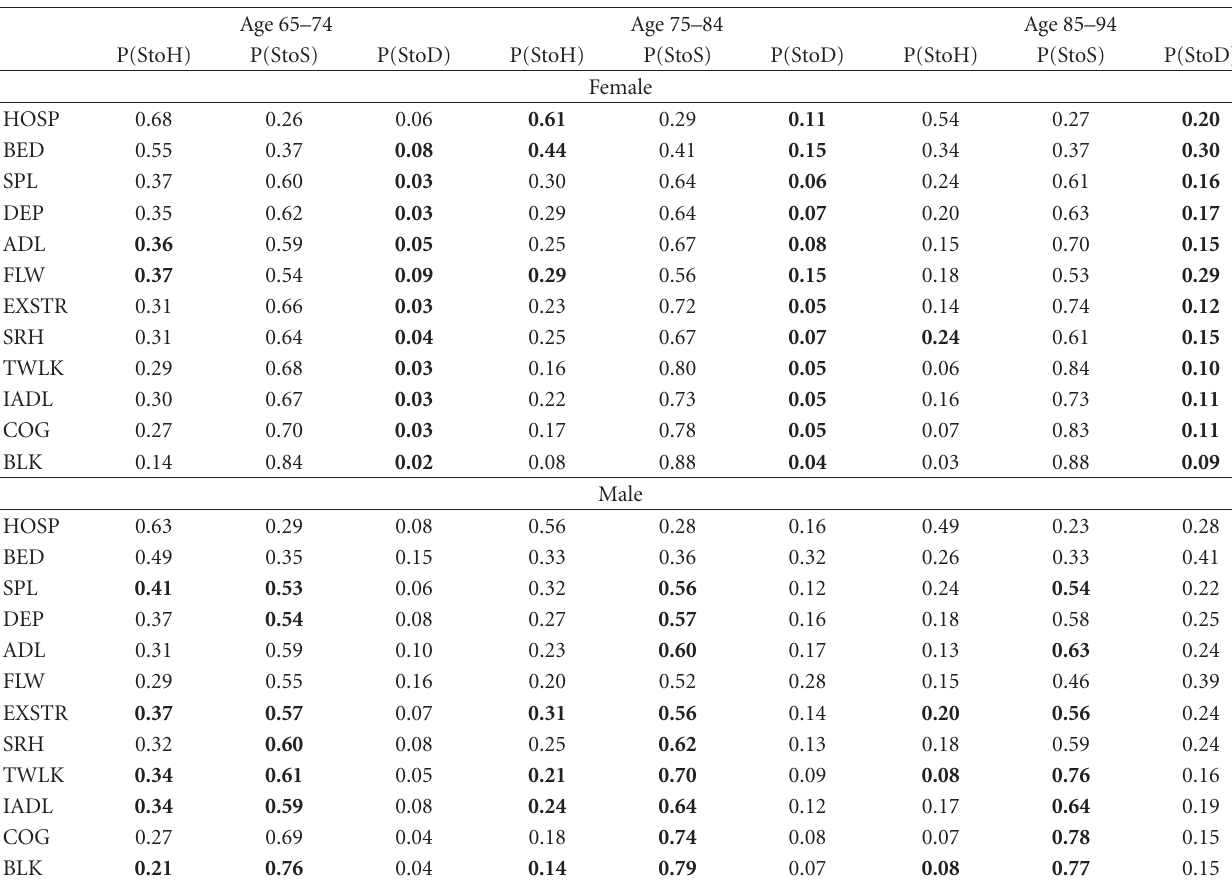
Table 4: One-year transition probabilities for those starting in a sick state for 12 di ff erent variables. Bolded entries indicate a